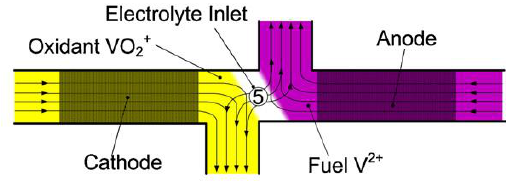
Figure 5. Counter flow microfluidic vanadium fuel cell design [16], Copyright Elsevier 2010.